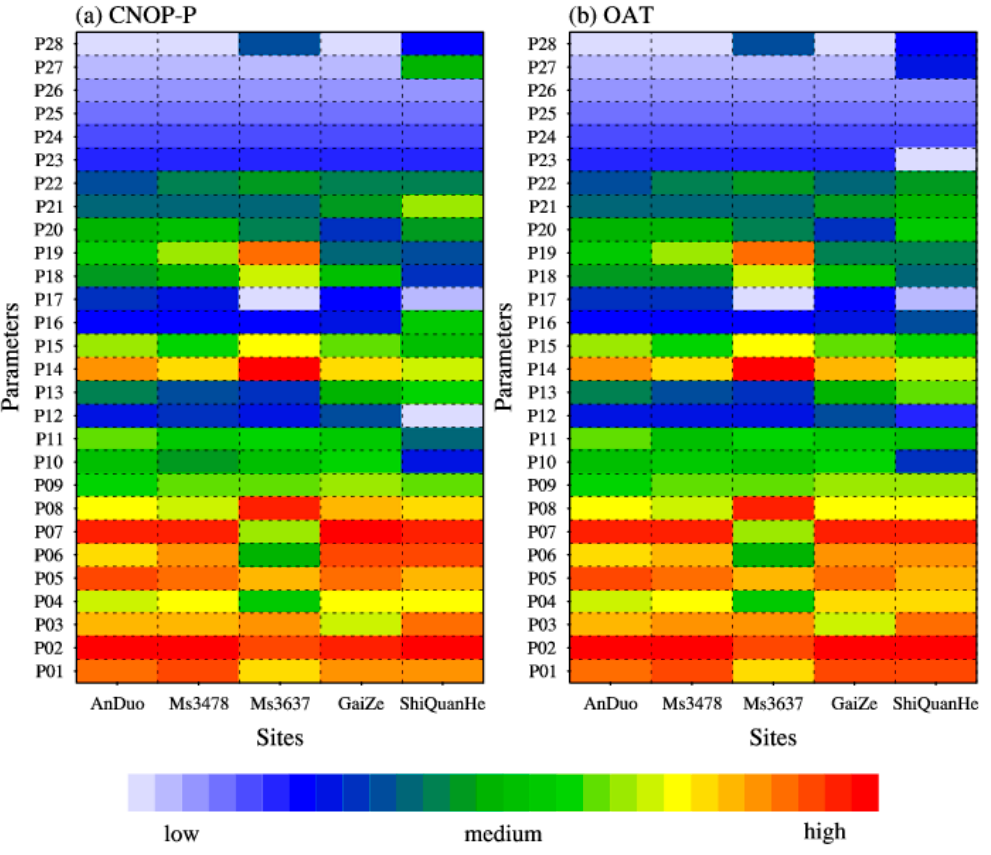
Figure 9. The ranks of the sensitivities of all 28 parameters based on single parameter sensitivity analyses using the CNOP-P approach ( a ) and the OAT method ( b ) for LH.